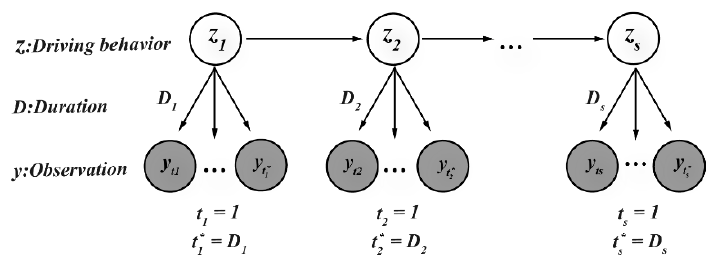
Figure 7. A graphical model of HSMM.